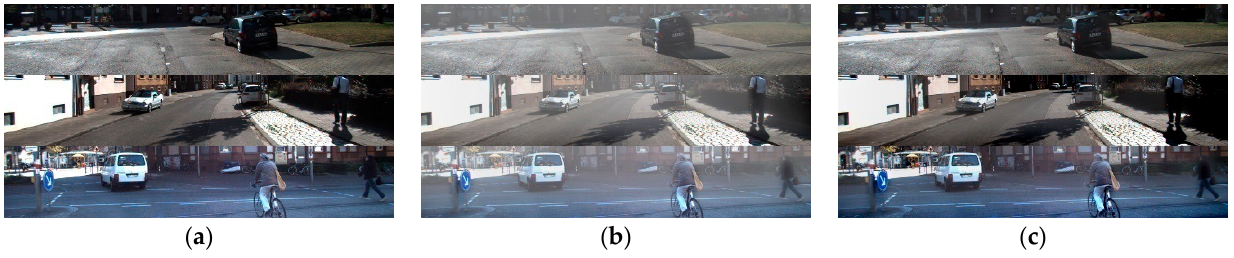
Figure 14. Hazy image with ground truth and dehazed image: ( a ) ground truth; ( b ) hazy image (c) dehazed image. Table 1. Quantitative analysis of improvement using first row image from Figure 14